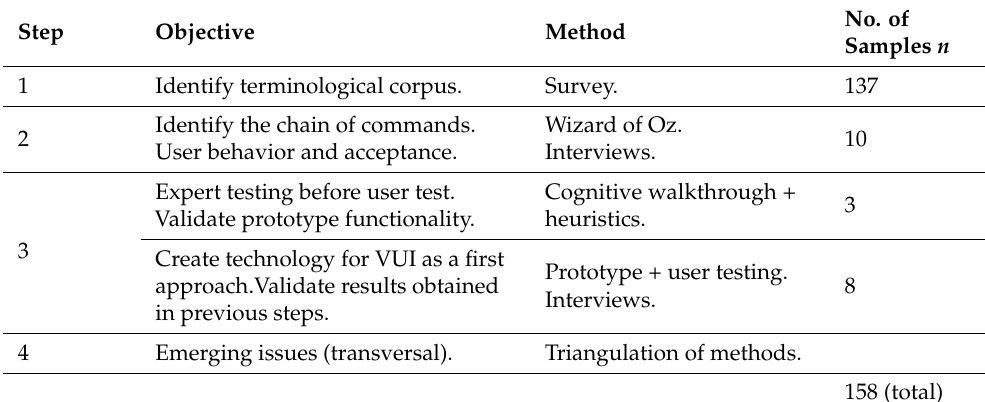
Table 1. Methods, dimensions, and objectives of our